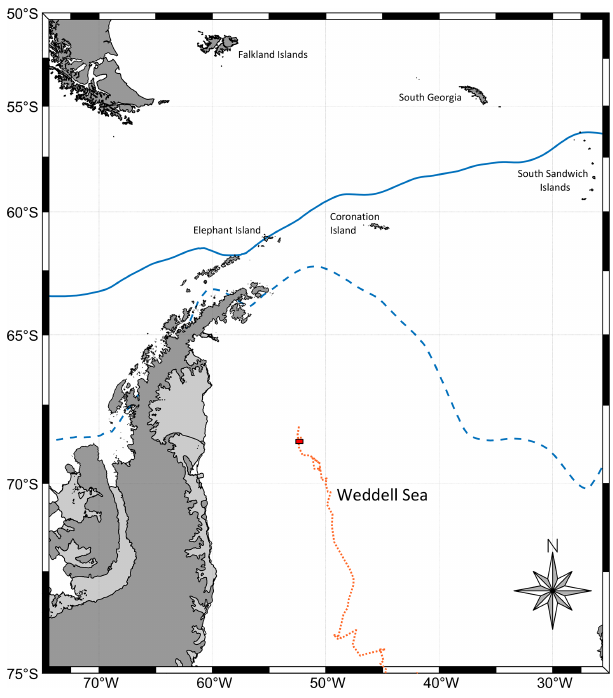
Figure 1. Map showing the geographical context and selected key features of the study domain. The drift track of Endurance (Dowdeswell et al., 2020) prior to sinking is shown in orange, with the Endurance22 search area shown in red. Solid (dashed) blue lines indicate the long-term average maximum (minimum) sea ice extent. They are based on long-term averages (daily climatology) computed from the EUMETSAT Ocean and Sea Ice Satellite Application Fa- cility’s (OSI-SAF) Sea Ice Concentration Climate Data Record v.3, accessed via the EU Copernicus CMEMS service (product code: